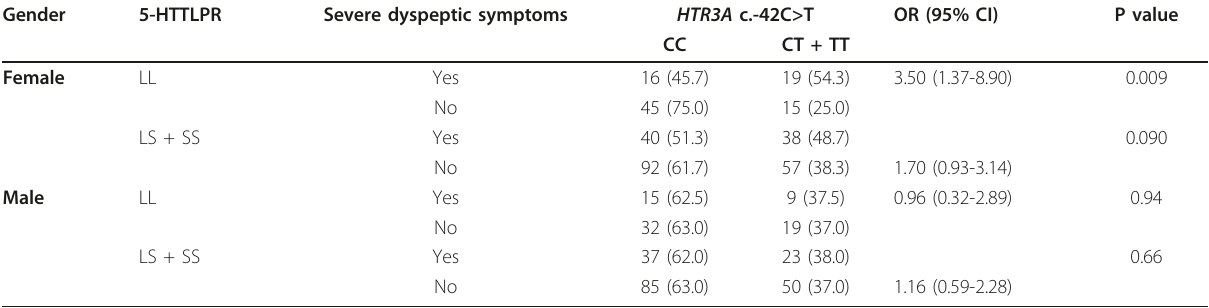
Table 5 Association between severe dyspeptic symptoms and HTR3A c.-42C > T genotype stratified by 5-HTTLPR genotype in females and